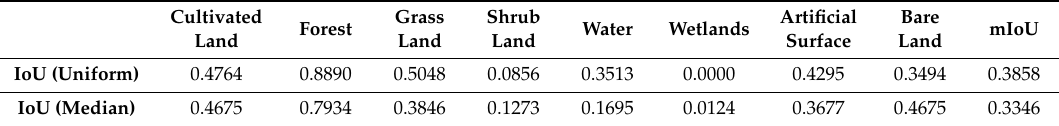
Table 6. Intersection over union (IoU) (uniform and median weights, Slovenia—8